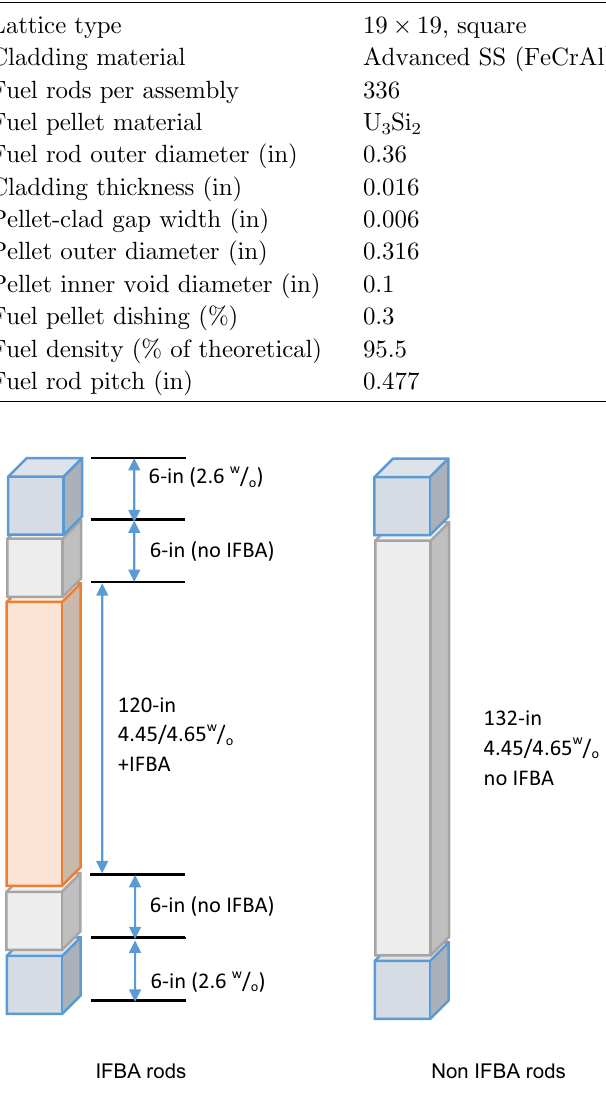
Fig. 2. I 2 S-LWR fuel axial stack.